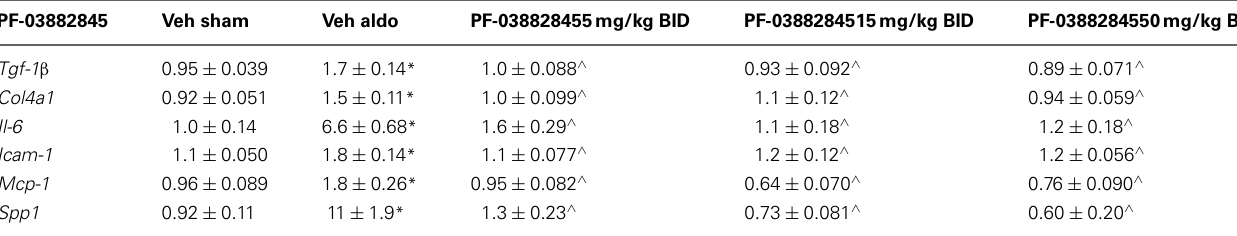
Values are mean relative quantitation ± standard error of the mean, n = 8–10/group. One-Way ANOVA with Tukey’s post-hoc analysis was performed. * Significantly